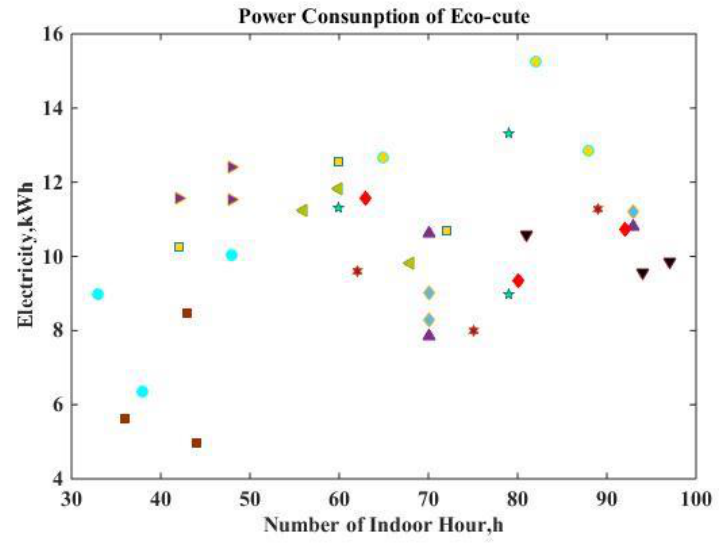
Figure 8. The impact of indoor hour on the Eco-cute